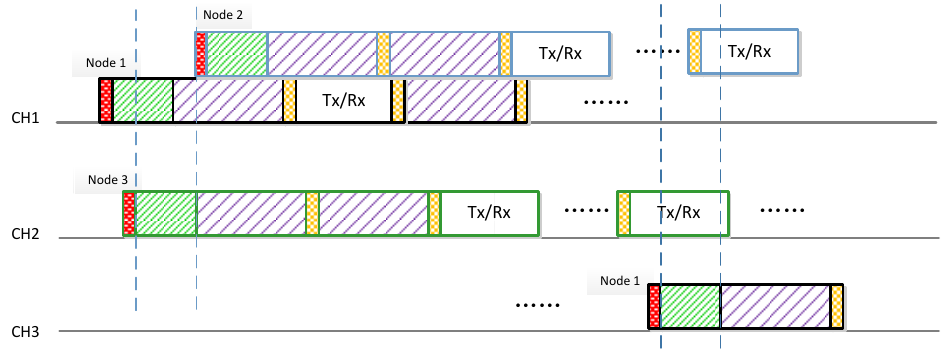
Figure 3. Desynchronization structure of the node .